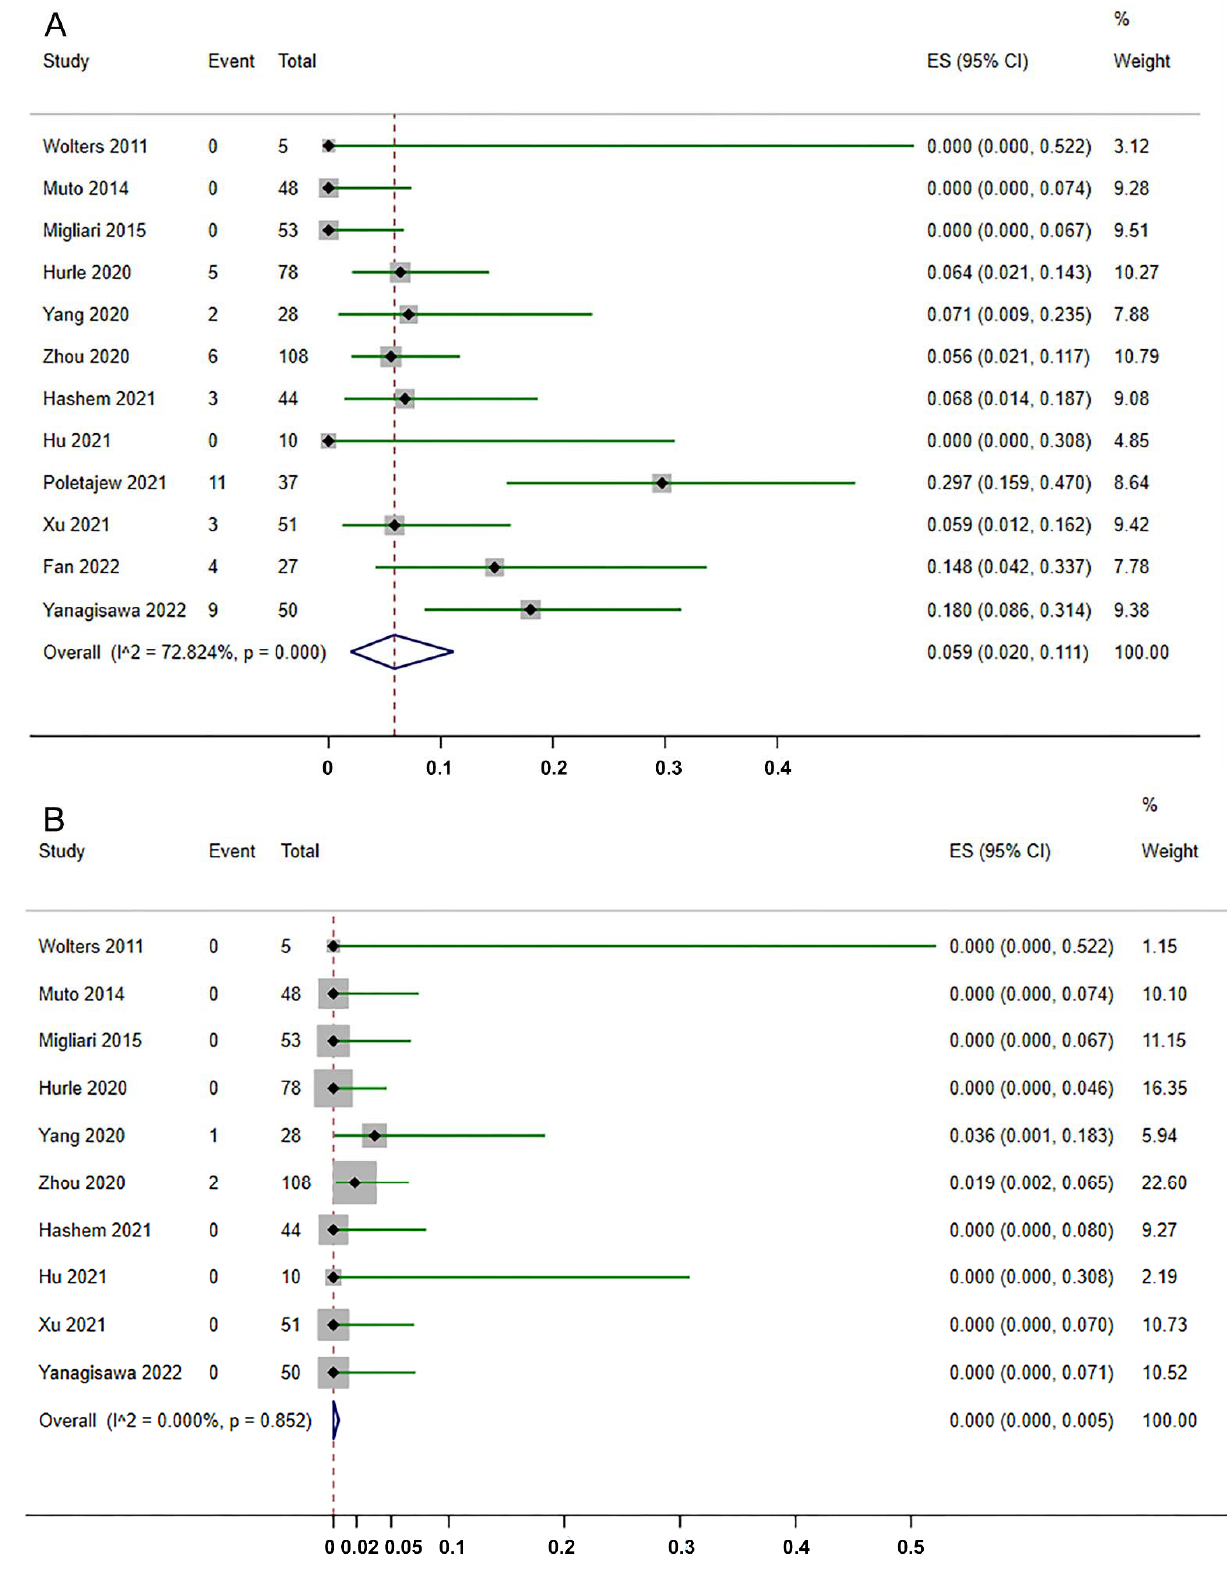
Figure 2. Forest plots of the rates of residual tumor ( A ) and tumor upstaging ( B ) detected by reTURB after initial ERBT [27–38]. ES: effect size. The dash lines represent the pooled effect